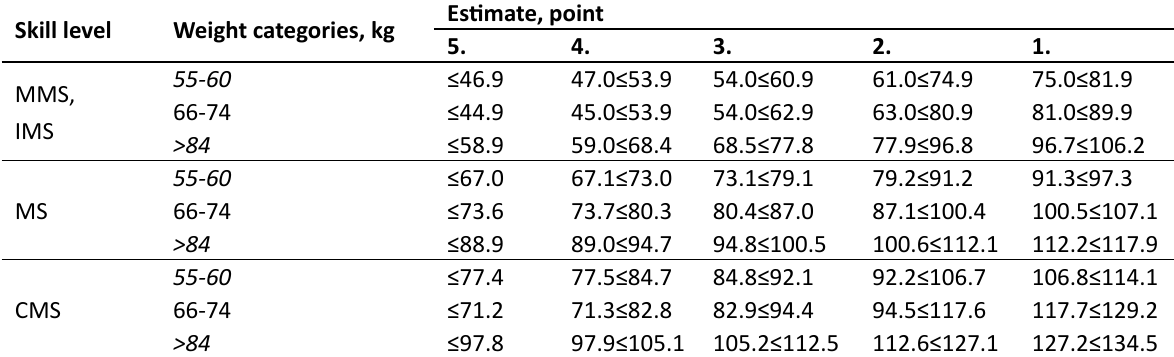
Table 2. Standard scales for assessing special work capacity of wrestlers of different skill level according to total time (sec) expended on execution of 45 one hand forward bending throws in 3 series (15 throws in each series) Skill